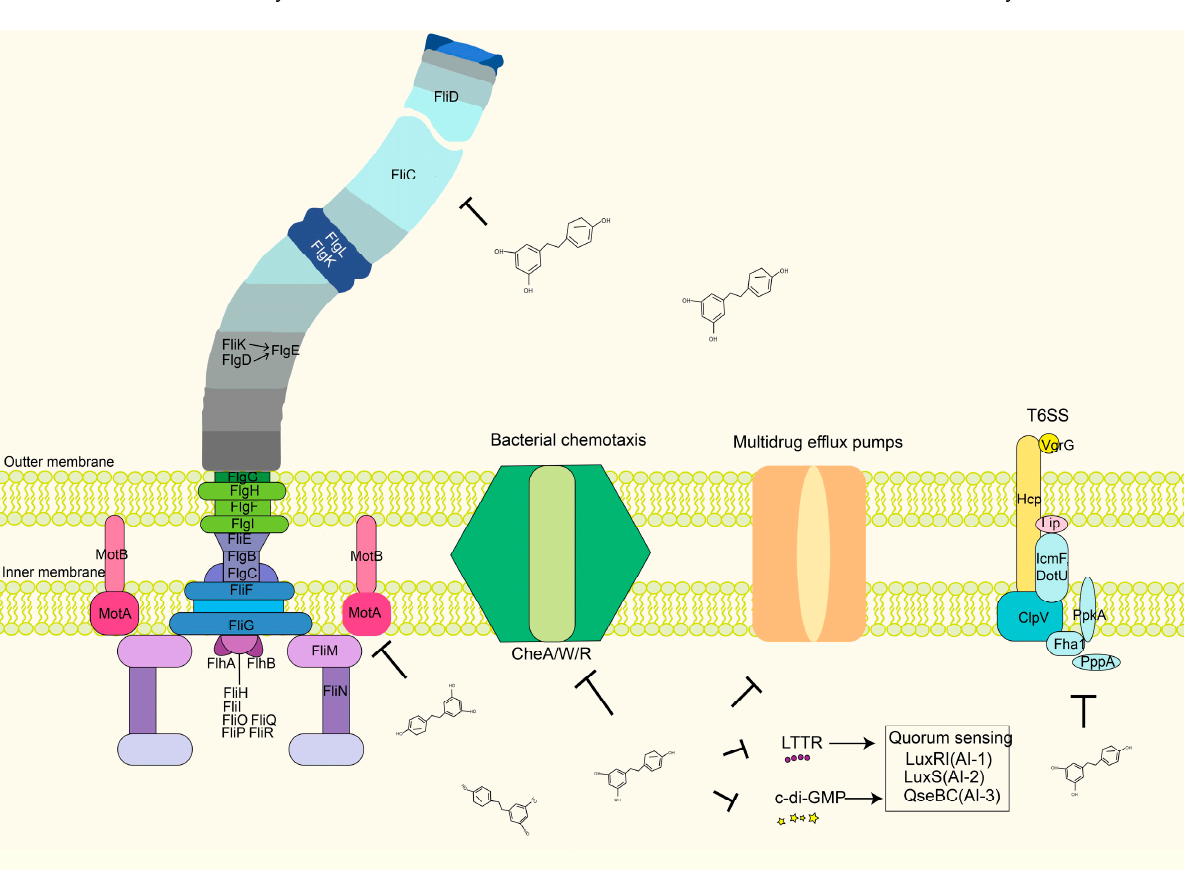
Figure 9. Schematic diagram of the inhibitory effects of resveratrol on A. hydrophila . “ ┬ ” denotes inhibition.